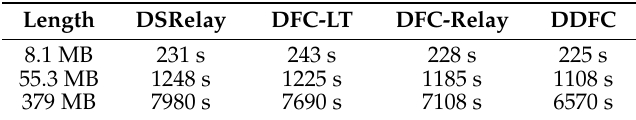
Table 1. Comparison of delay downloading files using the four methods.